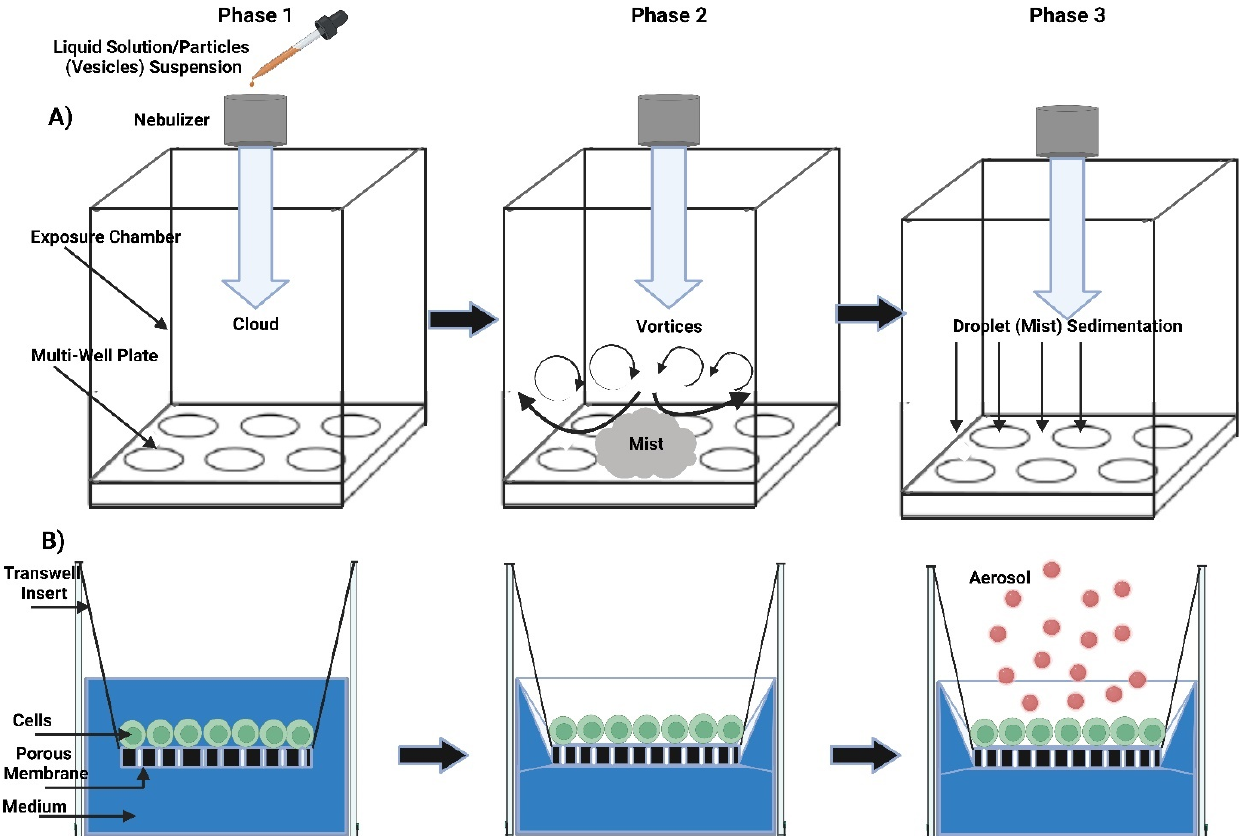
Figure 14. Schematic representation: ( A ) Nebulization and sedimentation of liquid solution/particles (vesicles) suspension using ALICE-CLOUD technology. ( B ) Cell cultivation on transwell inserts. Table 3. Summary of in vitro pulmonary cell-based models for testing inhaled aerosolized mist/dried lipid bilayer vesicles.